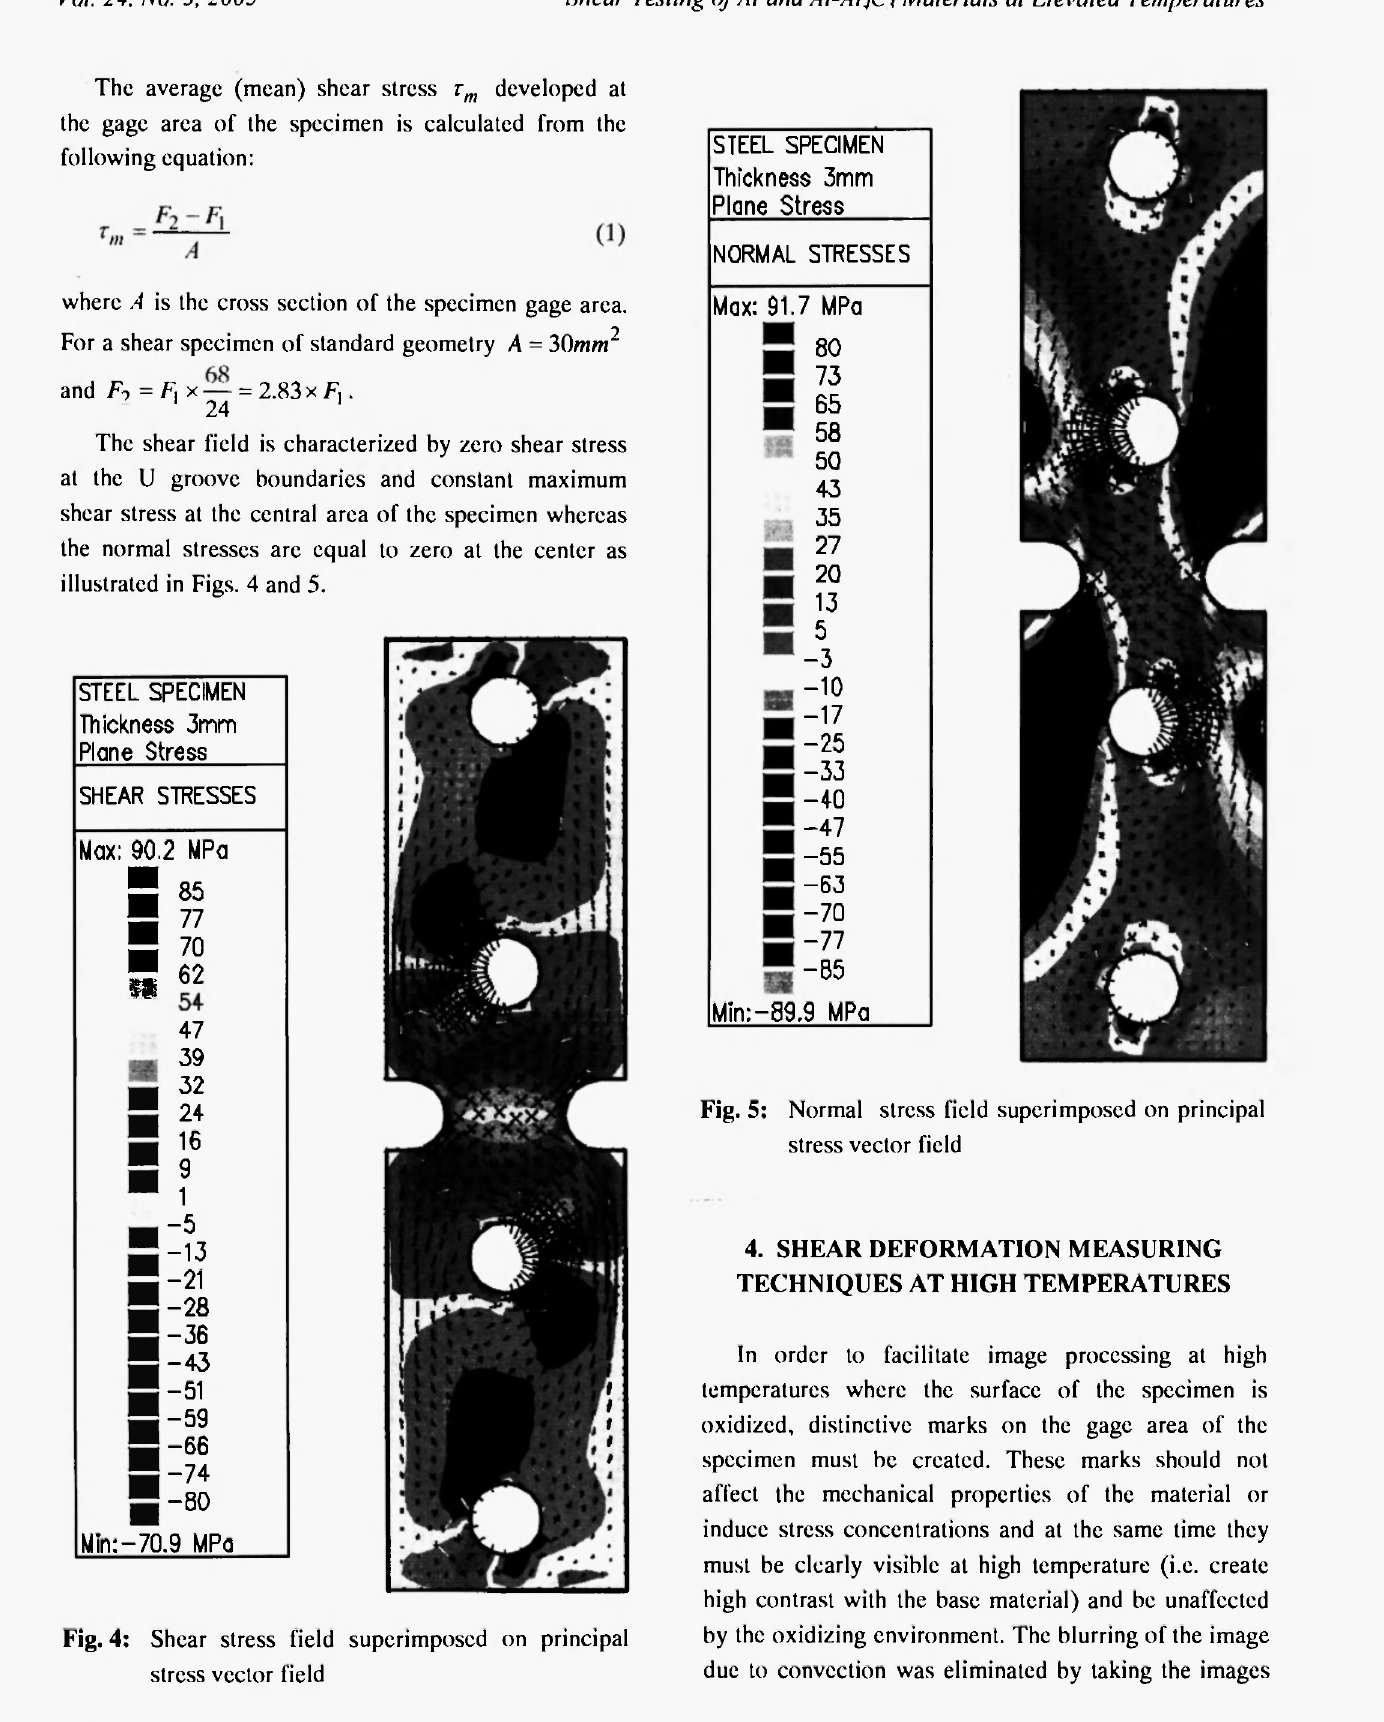
Fig. 4: Shear stress field superimposed on principal stress vector